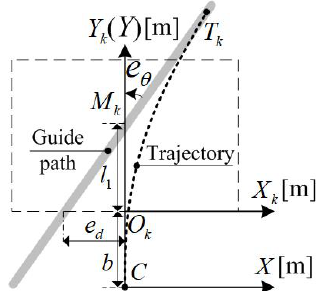
Figure 3. Path approaching within the field of view.